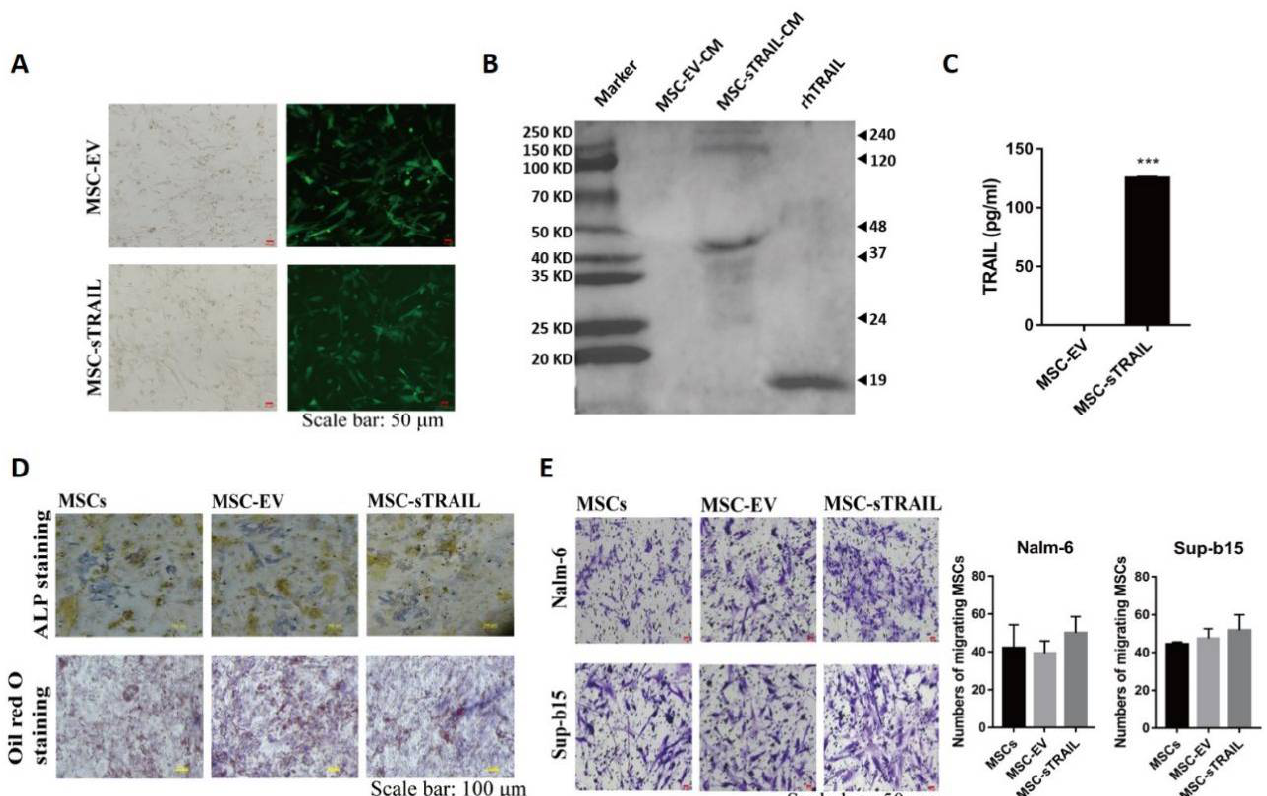
Figure 1. The successful construction of MSC-sTRAIL and lentiviral infection do not affect the biological properties of MSCs. After infecting MSCs with lentivirus: ( A ) White light and fluorescence micrographs of MSCs at day 5 after lentiviral infection (Scale bar 50 µ m). ( B ) The expression of TRAIL protein in MSC-sTRAIL-CM on the fifth day of infection was measured by western blotting. ( C ) The concentration of TRAIL in conditional medium was determined by ELISA (n = 3 per group; Student’s t test, ***, p < 0.001, MSC-sTRAIL-CM group compared with MSC-EV-CM group). ( D , E ) Staining plots for induction of adipogenic and osteogenic differentiation and homing of MSCs, MSC-EV, and MSC-sTRAIL (Scale bar: 100 µ m, and 50 µ m for ( D , E ),